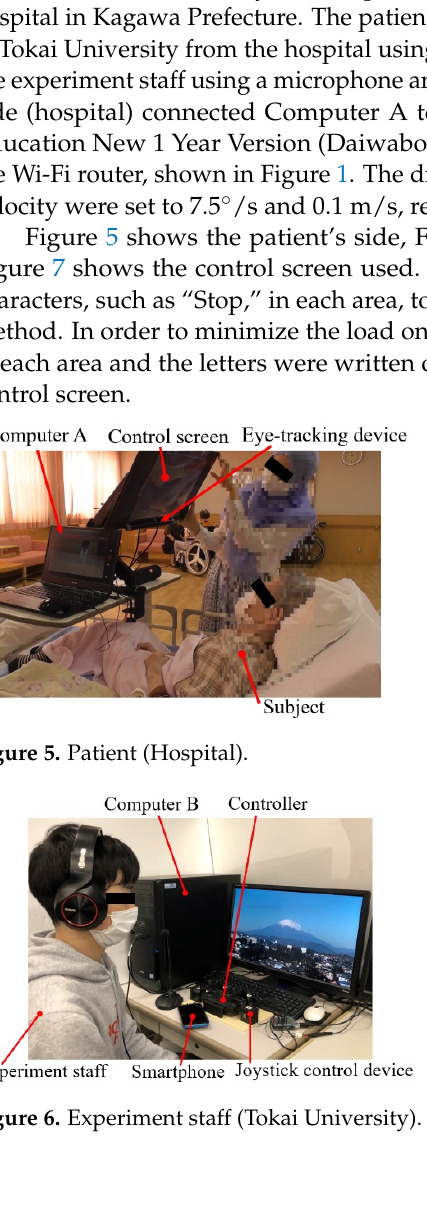
Figure 7. Control screen used in this experiment. The experimental procedure was as follows: First, we instructed the patients on the control method of the drone and the flight course. Next, the eye-tracking device was calibrated for each patient, and then we started the experiment to control the drone using only eye movements. After the experiment, the patients were asked to complete a questionnaire about their evaluation of the system. Figure 8 shows the flight course in this indoor experiment. The patients operated the drone according to the following procedure, based on instructions from the experiment staff: (i). The drone took off and rose to a height of 1.2 m, controlled by the experiment staff. After that, the patient looked at Area 3, according to the experiment staff’s instructions. (ii). After rotating the drone to the right at the preset rotational velocity, the patient looked at Area 4, according to the experiment staff’s instructions. (iii). After rotating the drone to the left at the preset rotational velocity, the patient looked at Area 5, according to the experiment staff’s instructions. (iv). After ascending the drone at the preset translational velocity, the patient looked at Area 6, according to the experiment staff’s instructions.